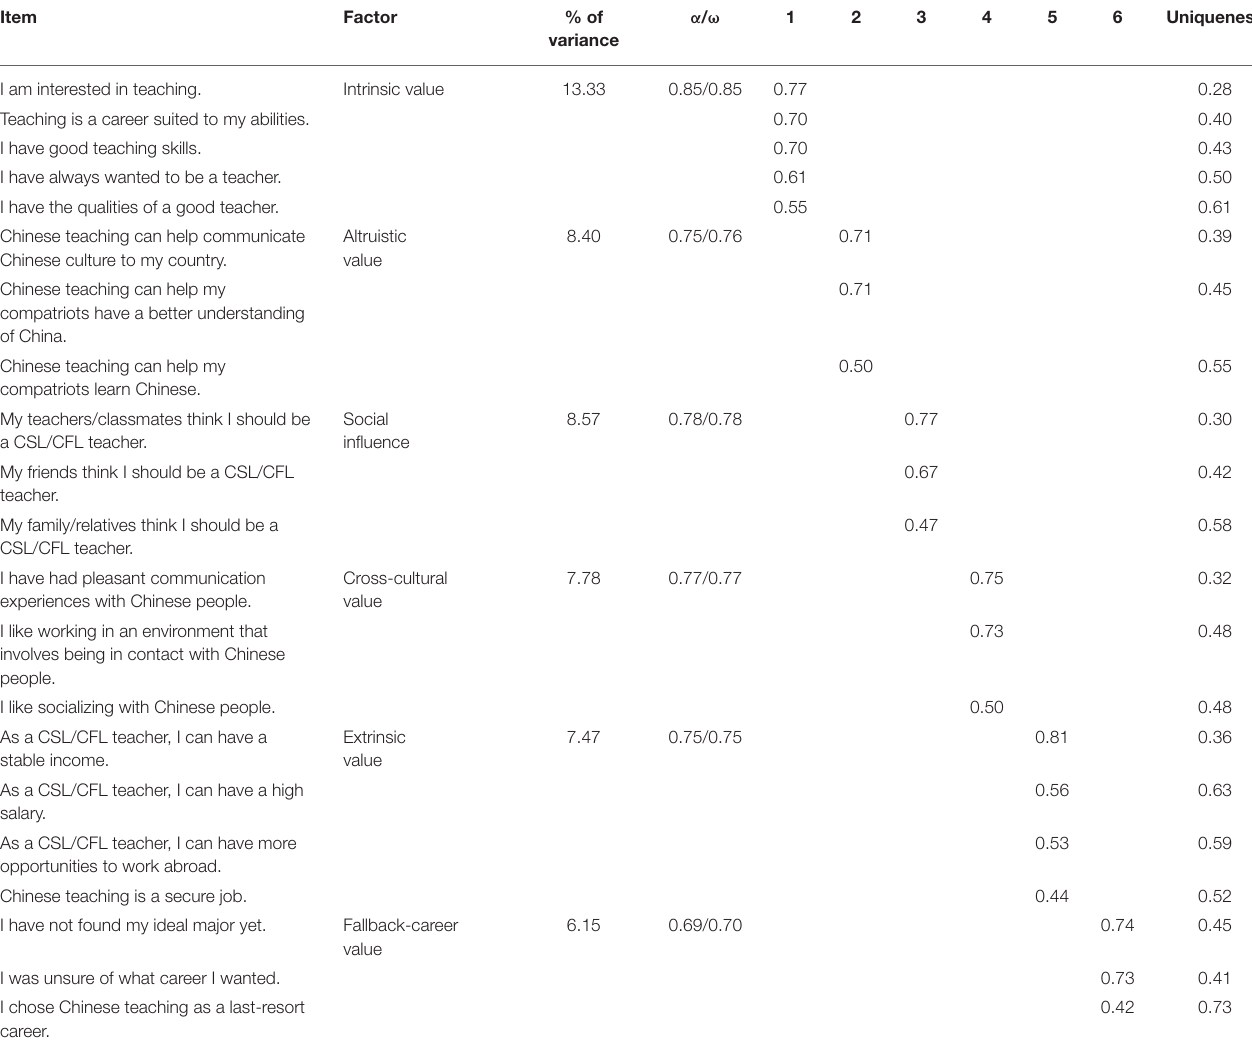
TABLE 5 | Summary of the factor loadings of EFA (non-native group). Item